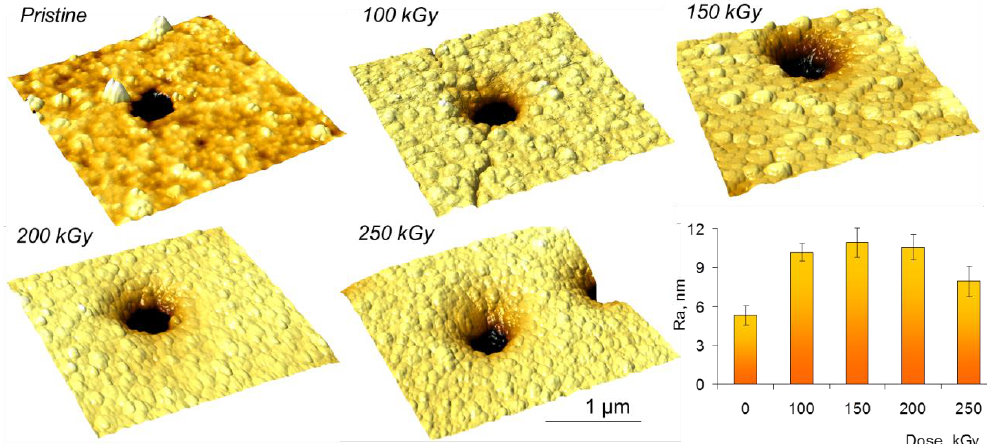
Figure 6. Atomic force microscopy (AFM) images of composite membranes with embedded Cu NTs (before and after e-beam irradiation) and the corresponding average value of roughness (inset).